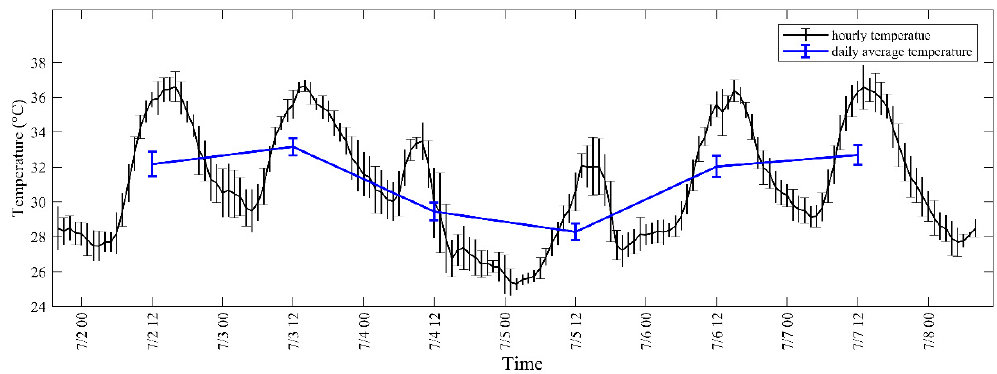
Figure 3. Shanghai hourly and daily mean temperature on 1–8 July 2011.